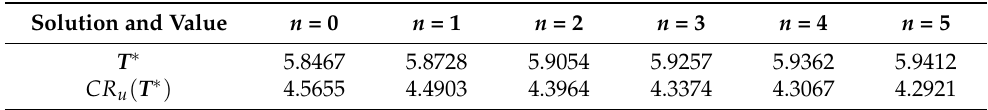
Table 2. Optimum solution and optimum